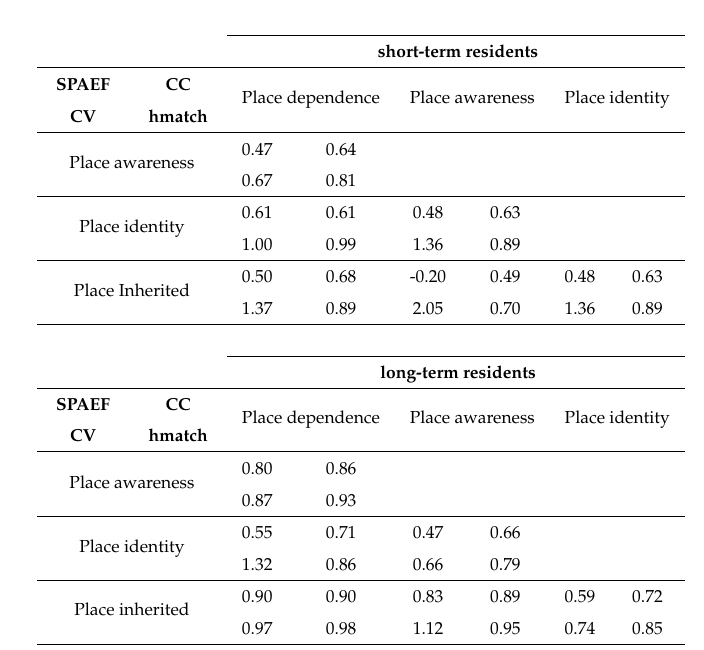
Table 6: Spatial Efficiency metric (SPAEF); Pearson correlation (CC); Ratio of coefficient of variation (CV); and histogram overlap (hmatch) between each dimension of sense of place within short-term residents (top) and long-term residents